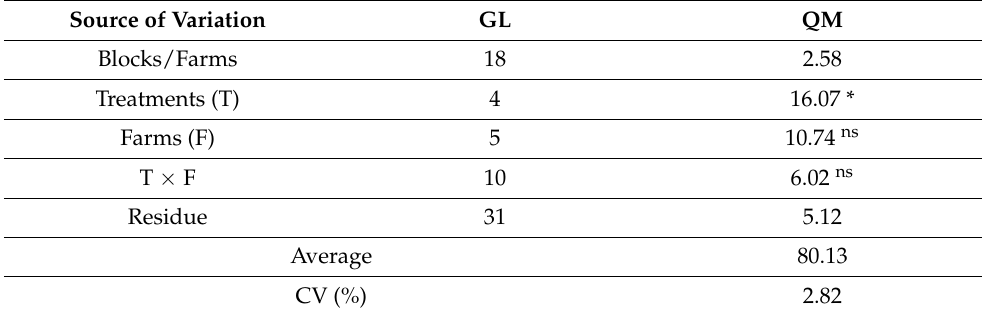
Figure A2. Mean accumulated rainfall in mm in the Conilon-producing areas under study. Location: Venda Nova do Imigrante (1), Castelo (2), Muniz Freire (3), Conceição do Castelo 1 (4), Vargem Alta (5), and Conceição do Castelo 2 (6). Table A1. Joint analysis of variance of the final score evaluated in six farms and five